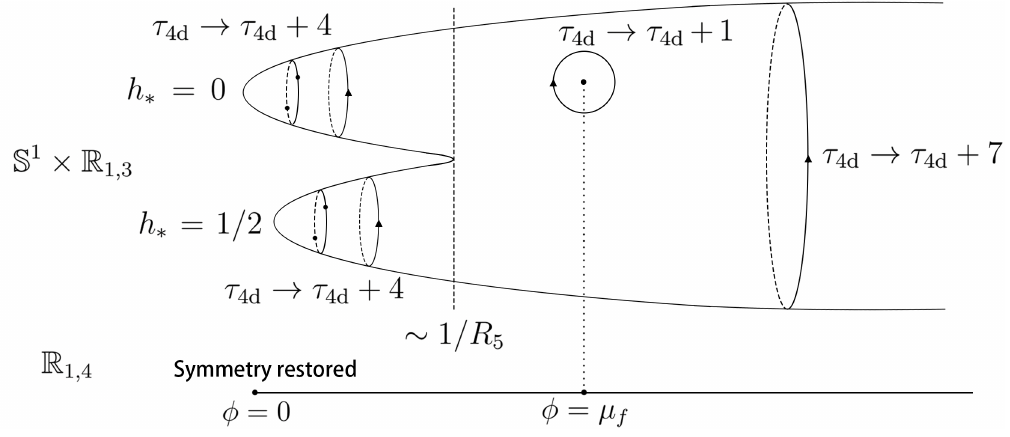
Figure 26 . Moduli space for dP 2 -theory with µ 0 , µ f > 0